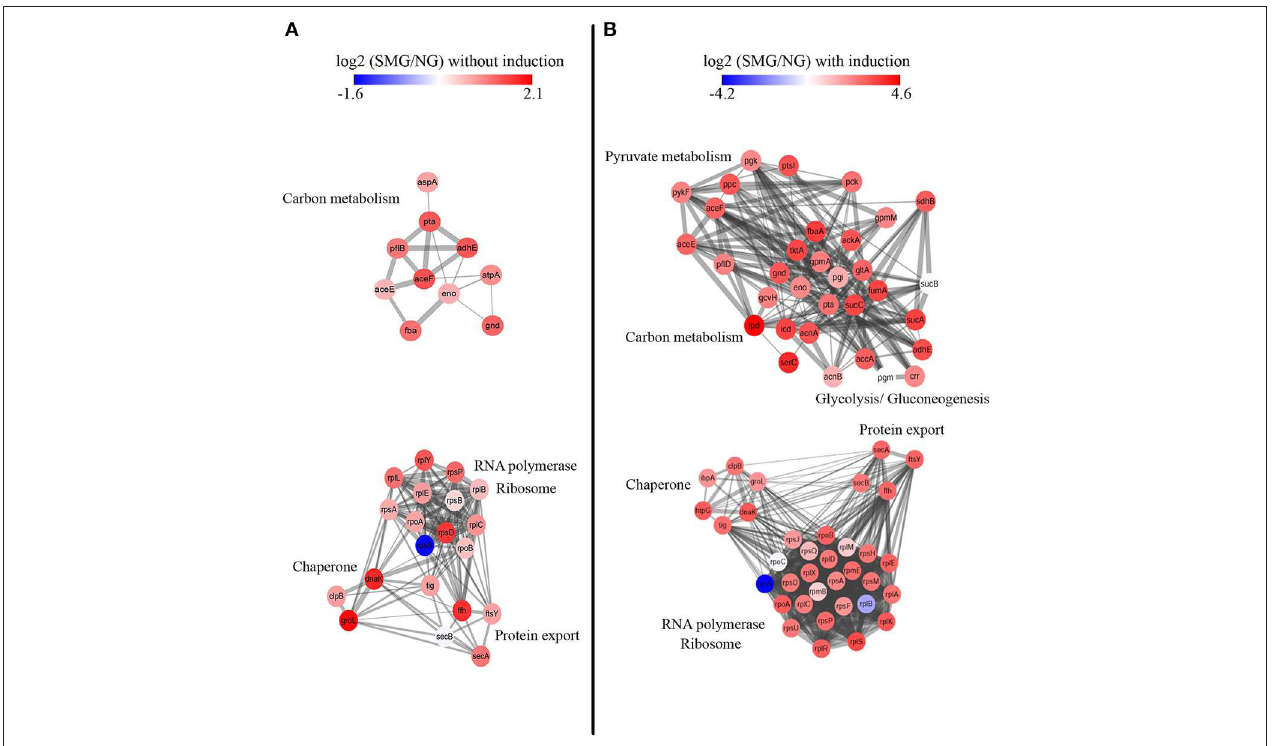
FIGURE 5 | Protein–protein interaction network analysis. STRING clusters represent proteins involved in carbon metabolism and RNA polymerase, ribosome, chaperone, and protein export. Proteins are colored either in red (representing upregulation) or in blue (representing downregulation) according to their differential expression levels. Left panel (A) is the proteins without IPTG induction, and right panel (B) is the proteins with IPTG induction.